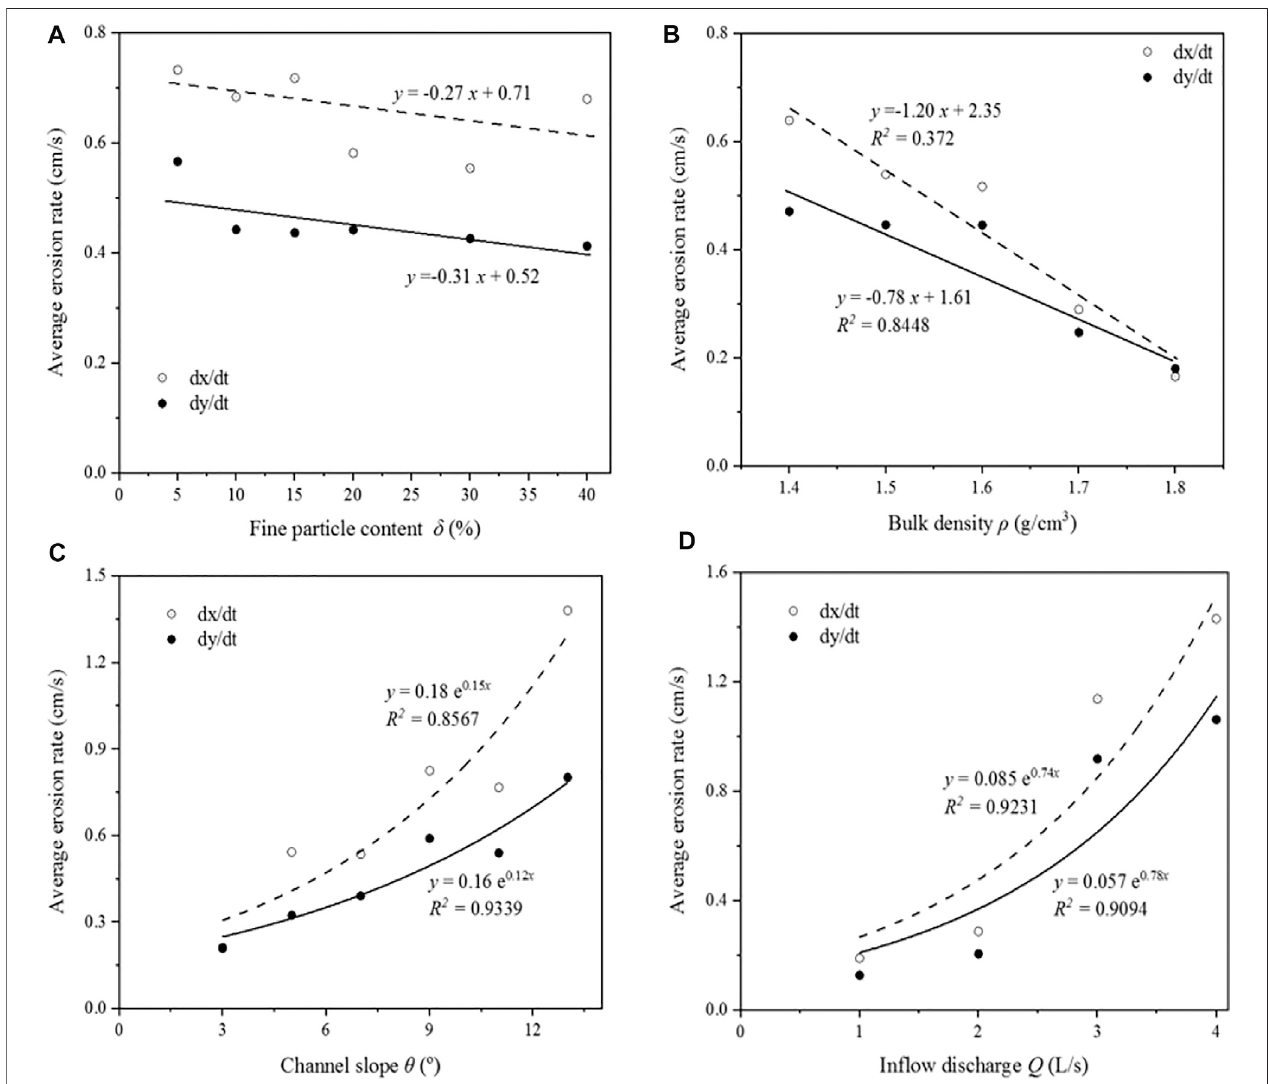
FIGURE 9 | Relationships between the average erosion rate and different in fl uencing factors.